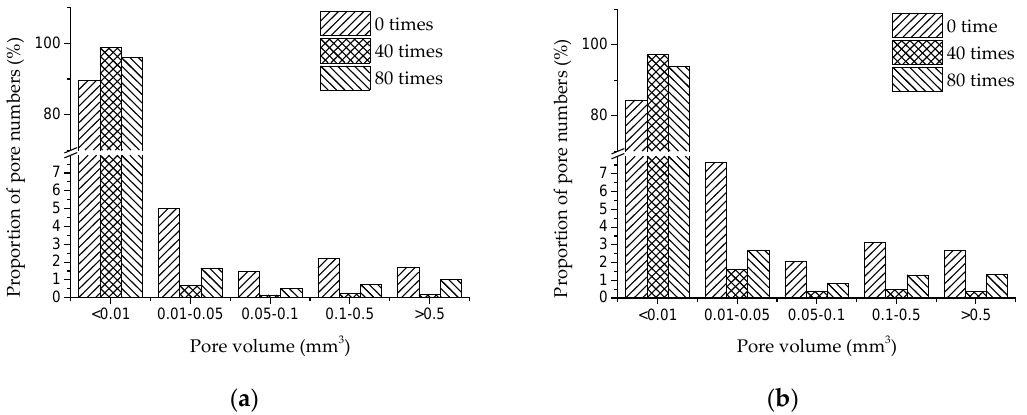
Figure 3. Proportion of pore numbers in concrete under dry and wet cycles of sulfate attack: ( a ) D5; ( b ) D4 .